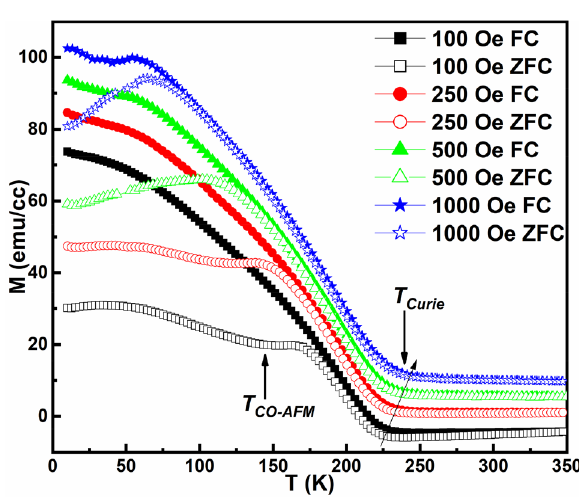
Figure 4. Temperature-dependent magnetization measurement at various applied magnetic fields for PSMO/ PCMO/STO